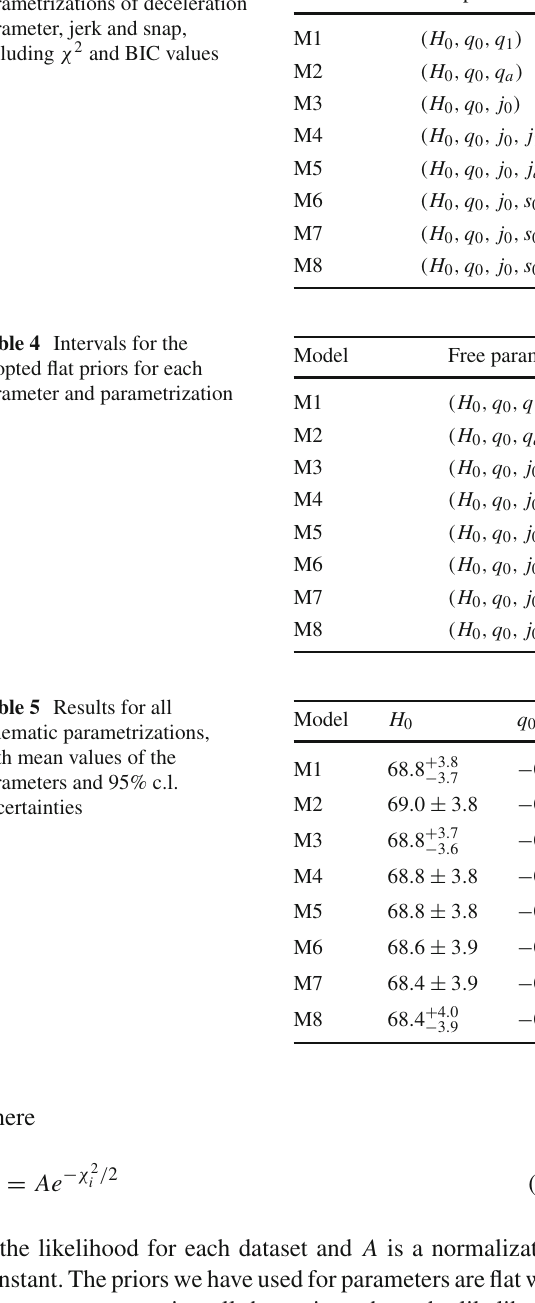
Table 3 Kinematic parametrizations of deceleration parameter, jerk and snap, including χ 2 and BIC values